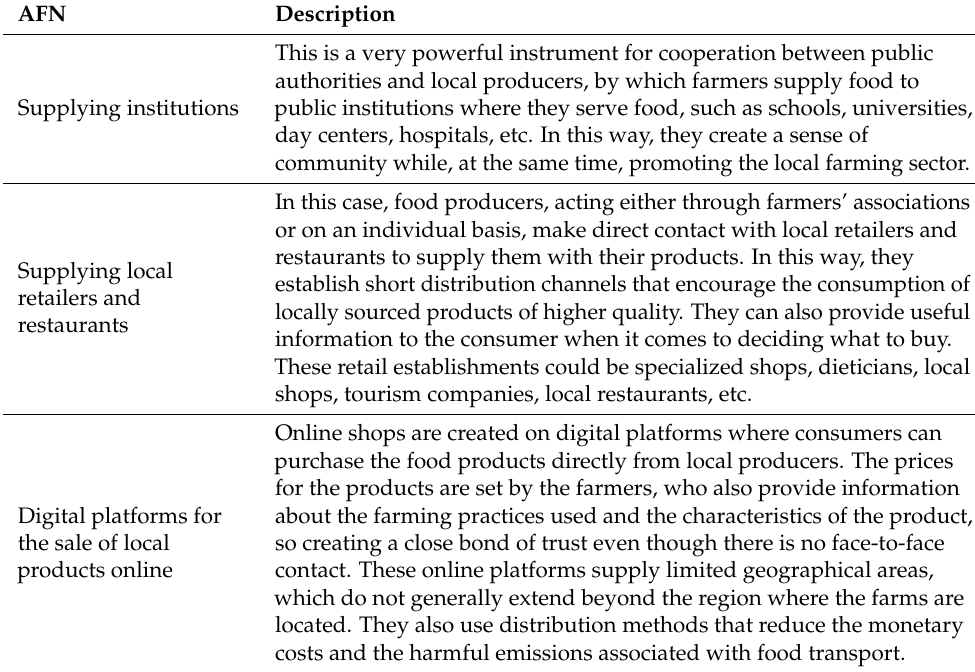
Table A1. Cont. AFN Description